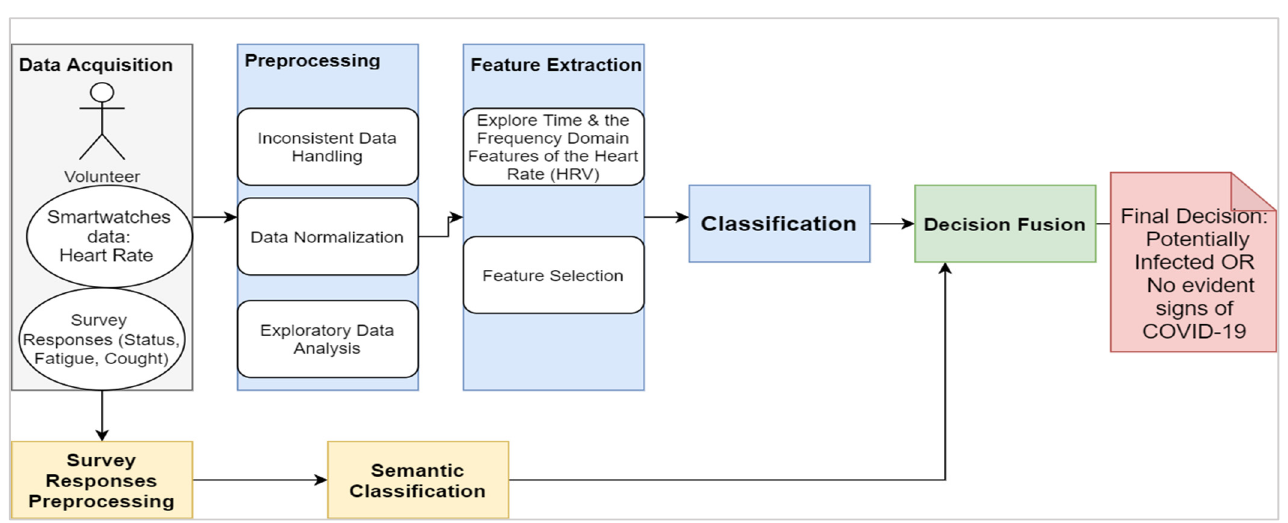
Figure 3. Schematic Representation of the Approach.